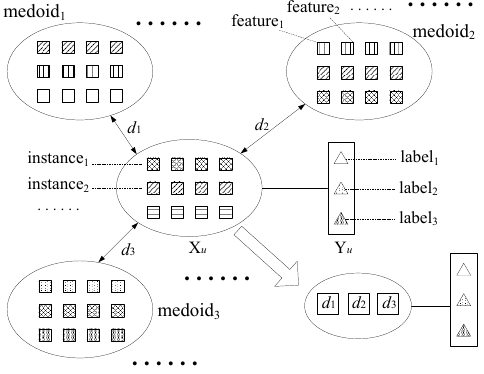
Figure 2. The process of transforming multi-instance examples into single-instance